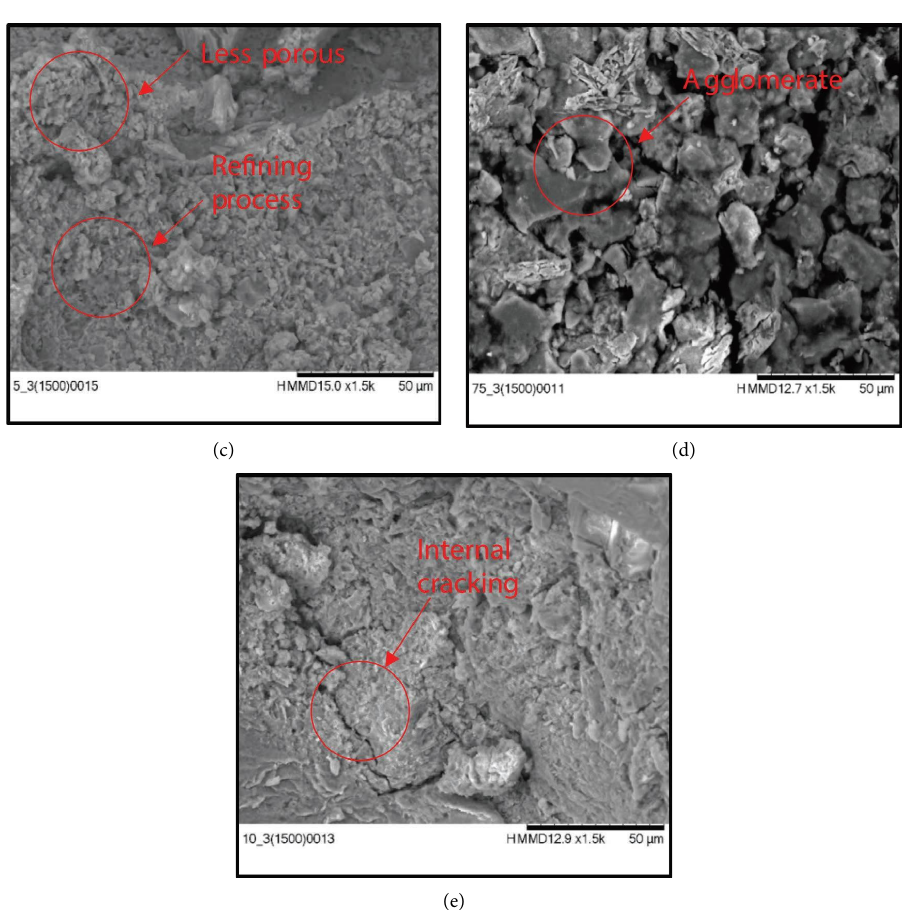
Figure 10: SEM micrographs of mortar on day 3 at 50 micron scale with 1500 magnifcation: (a) 0% POFA, (b) 2.5% POFA, (c) 5% POFA, (d) 7.5% POFA, and (e) 10%